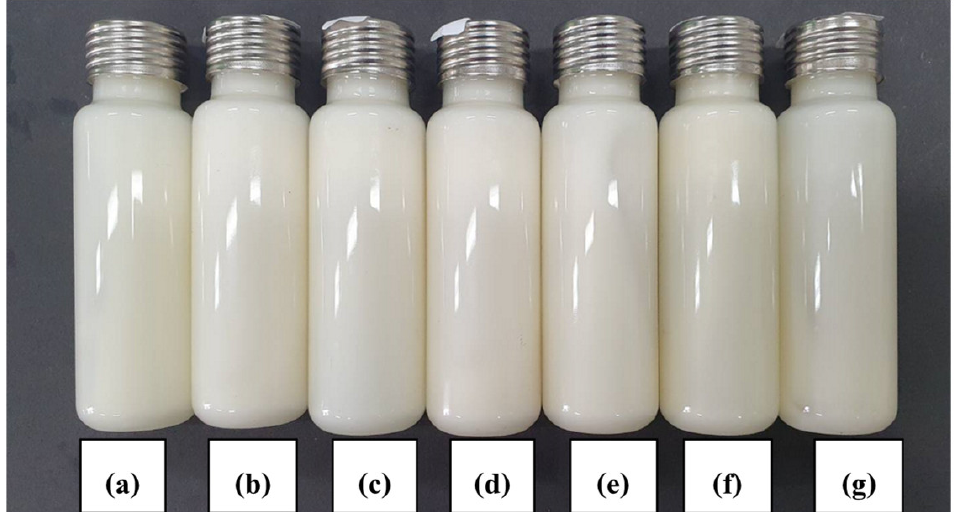
Figure 2. Deodorant cream with 0.5% H-CMCH by heating/cooling cycle; ( a ) cycle 0, ( b ) cycle 1, ( c ) cycle 2, ( d ) cycle 3, ( e ) cycle 4, ( f ) cycle 5, and ( g ) cycle 6.